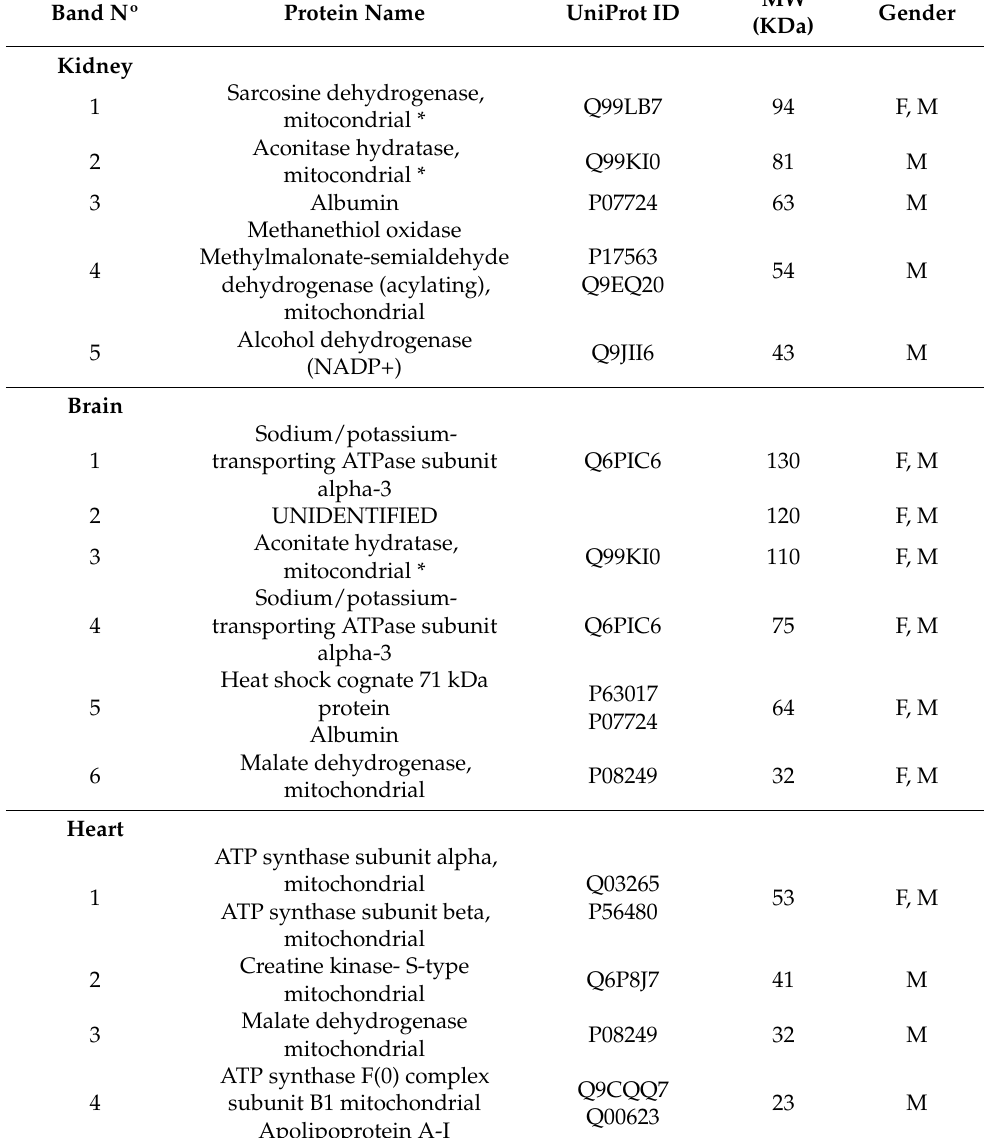
(Table 2). Band 3, mitochondrial aconitase hydratase (EC:4.2.1.3), catalyses the conversion of citrate to isocitrate in the tricarboxylic acid (TCA) cycle. In band 5, two proteins were identified: heat shock cognate 71 kDa protein with a key role in protein quality control system and serum albumin, which was also found in kidney as band 3. In band 6 was identified mitochondrial malate dehydrogenase (EC:1.1.1.37) which, as the final step in the TCA cycle, reversibly catalyses the NAD/NADH-dependent oxidation of malate to oxaloacetate. Table 2. Identification of 4-HNE-modified proteins in Hfe − / − mice organs. Band Nº Protein Name UniProt ID